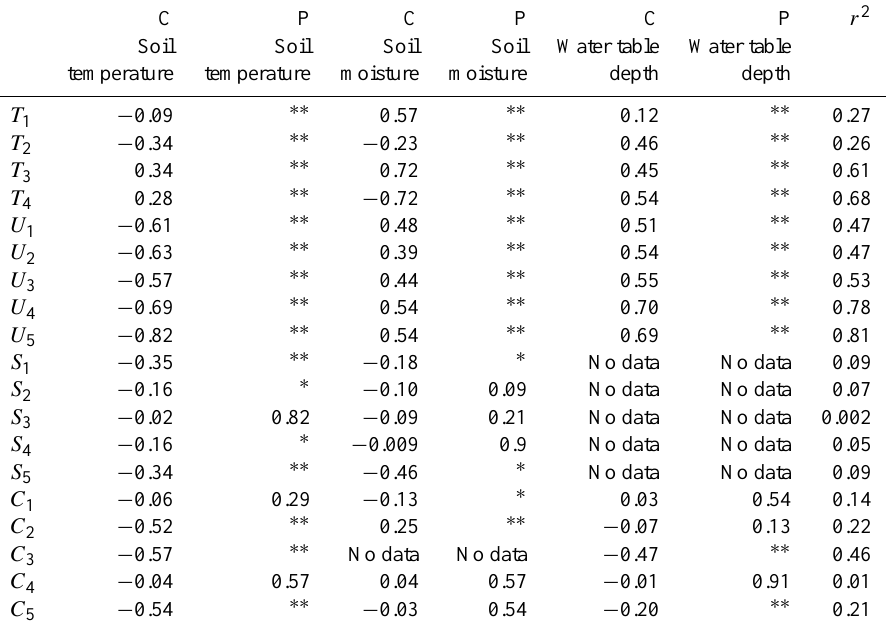
Table 2. Correlation coefficients C and corresponding P values for the linear regressions between CH 4 exchange and soil temperature, soil moisture and water table depth. The r 2 shows how well the combined variables explain the variance in the CH 4 exchange. The correlation analyses are based on data from the entire measurement period.